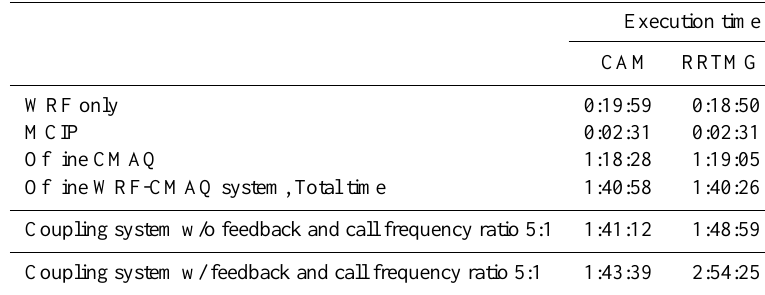
Table 1. Performance of the uncoupled and coupled system (hh:mm:ss) on a linux cluster.